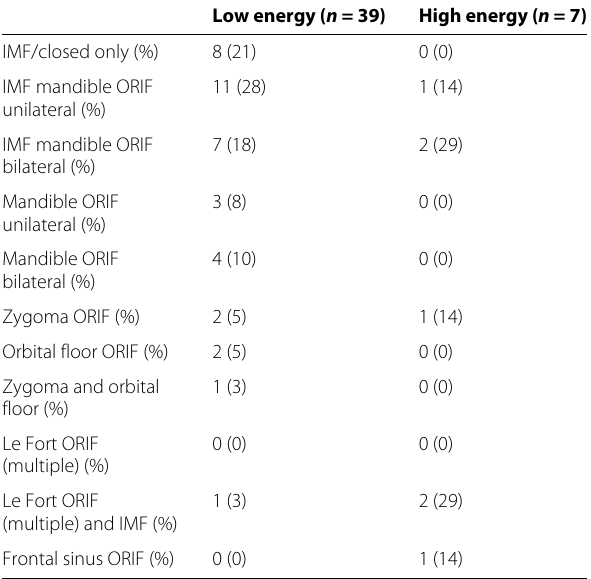
Table 4 Procedure